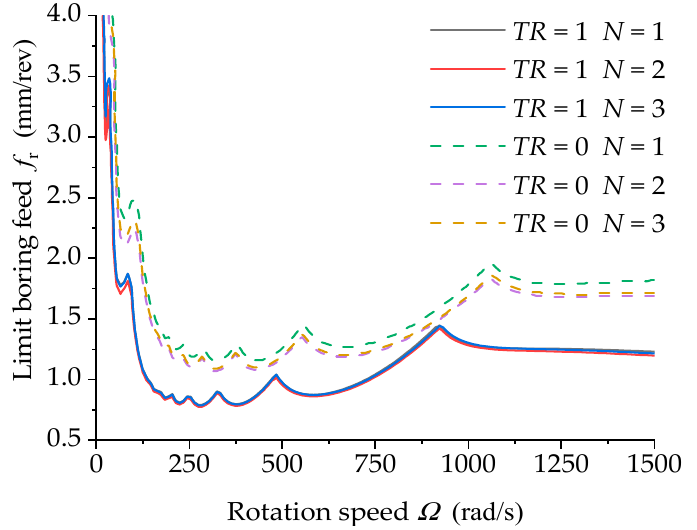
Figure 11. Effect of the number of vibration mode functions on the stability lobe diagrams of the rotated composite boring bar ( ψ = 1 and L/d = 10).